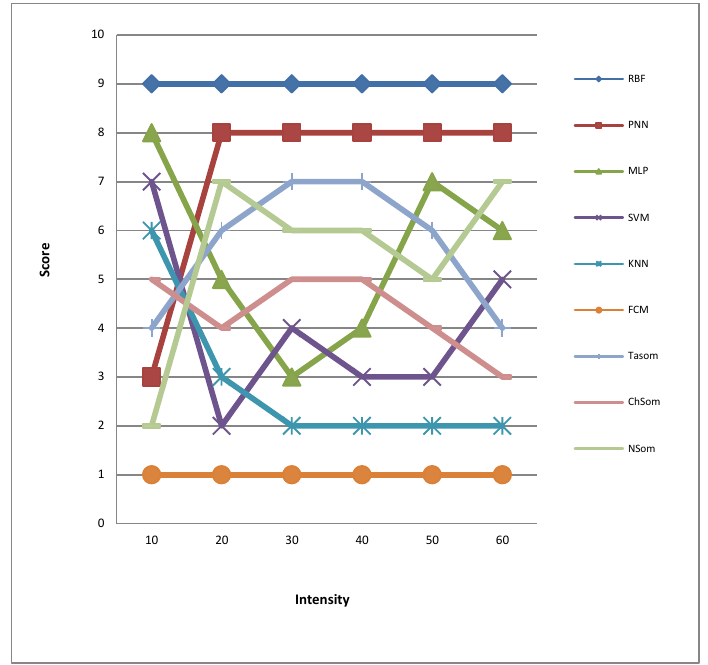
better results. By the way, TWP has been assigned to an average rank but has a good result.